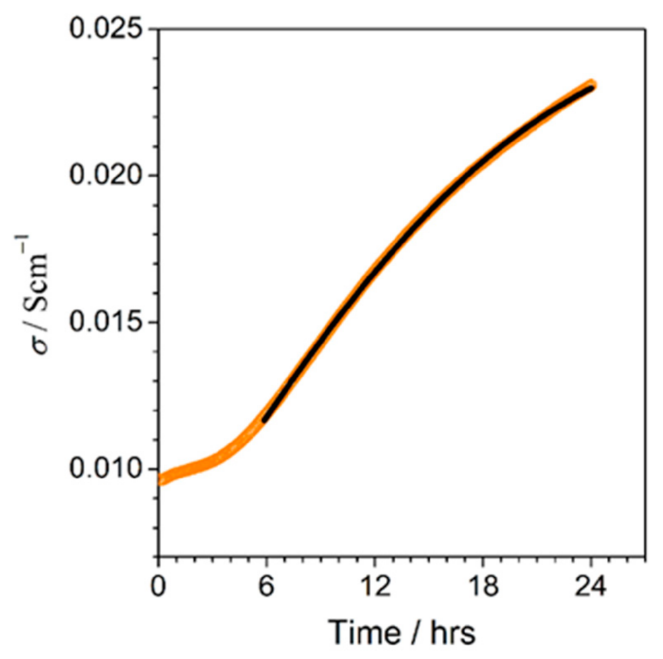
Figure 3. Conductivity increase vs. time during the isothermal annealing of a 90 V 2 O 5 · 10P 2 O 5 glassy sample at 240 ◦ C (orange circles) with a fit (solid black line) (Reproduced with permission from ref. [37]. Copyright 2013,